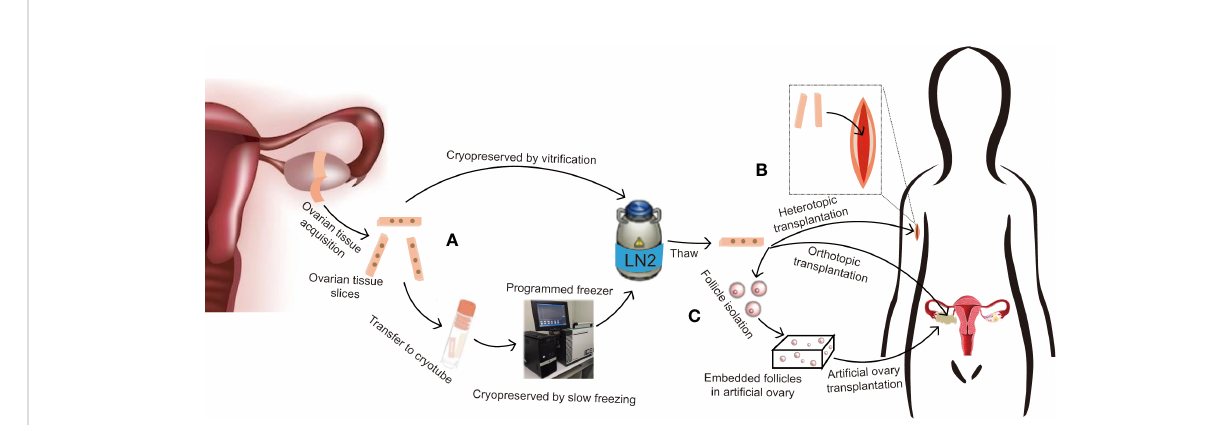
FIGURE 1 Protocol for ovarian tissue cryopreservation to preserve fertility and restore endocrine function. (A) If the patient is prepubertal or requires immediate chemotherapy with a potential risk of transmitting malignant cells, ovarian tissue slices are removed and long-term cryopreserved in liquid nitrogen by slow freezing or vitri fi cation. (B) After thawing, if there is no risk of transmitting malignant cells, the ovarian tissue can be used for orthotopic transplantation for natural pregnancy and to restore endocrine function, or heterotopic transplantation for further in vitro fertilization or hormone replacement therapy only. (C) If there is a risk of transmitting malignant cells, follicles can be isolated from cryopreserved tissue and embedded in an arti fi cial ovary, then transplanted into orthotopic or heterotopic sites for fertility preservation and endocrine function